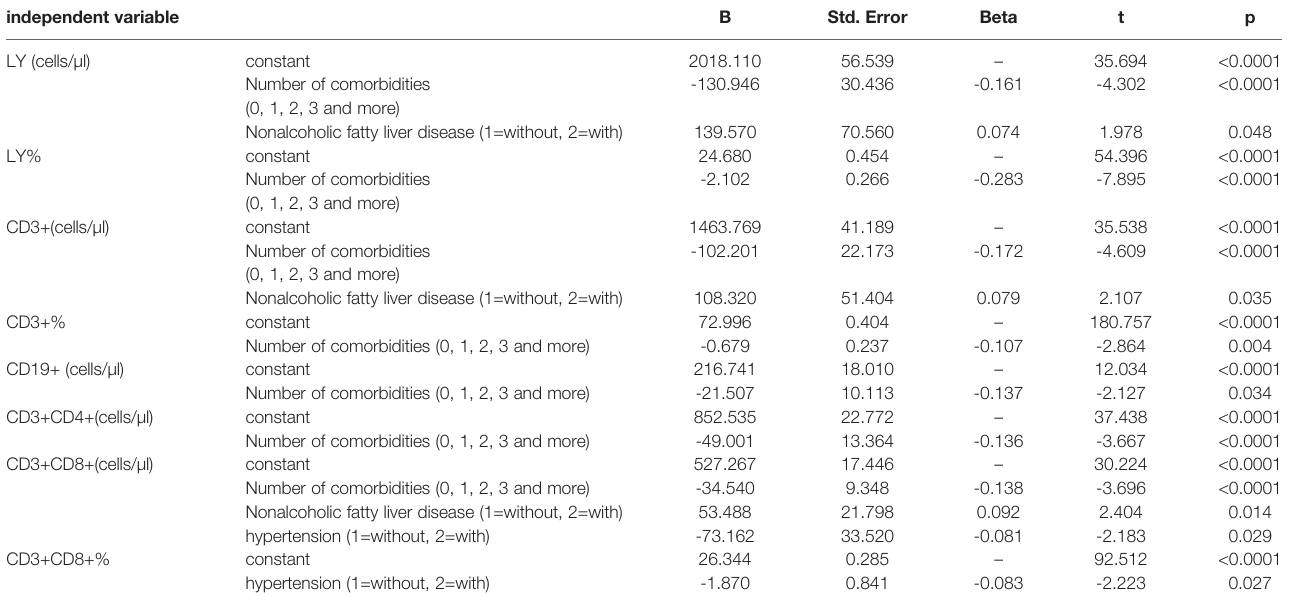
TABLE 5 | Multiple stepwise regression analysis of comorbidities in fl uencing lymphocyte and subsets (n = 718) . independent